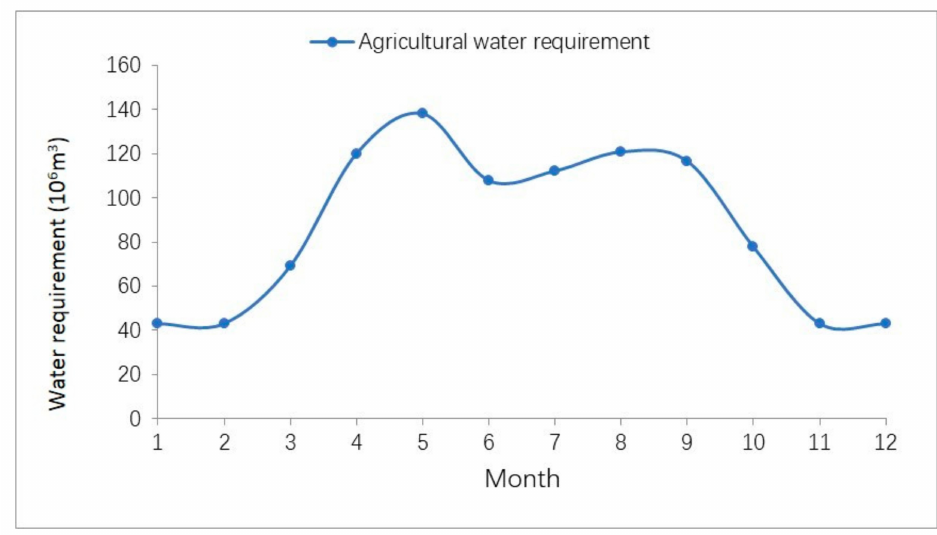
Figure 5. Water requirements under 50% precipitation frequency.